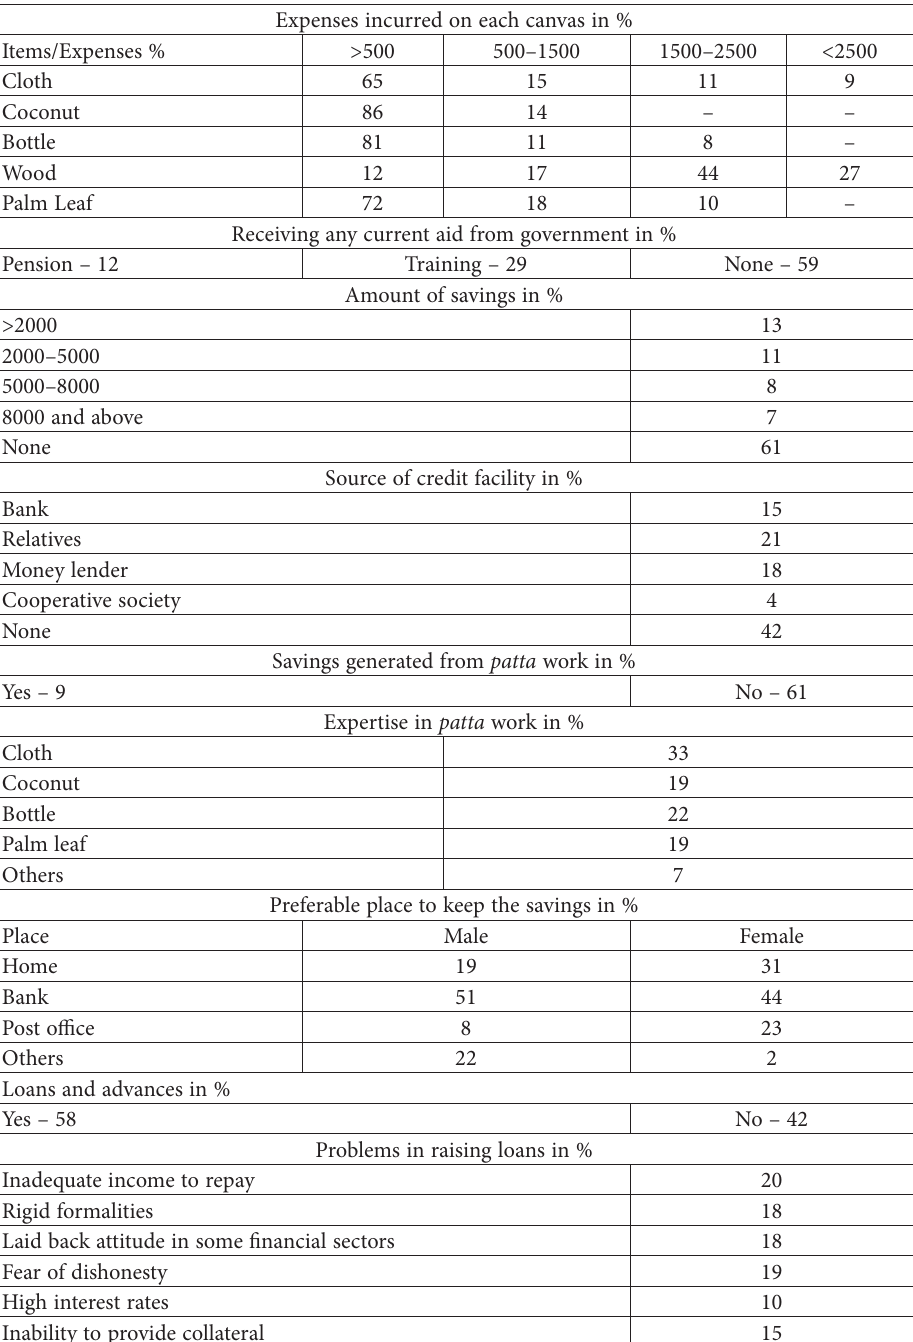
Table 1. Profile of financial scarcity and accessibility (source: created by